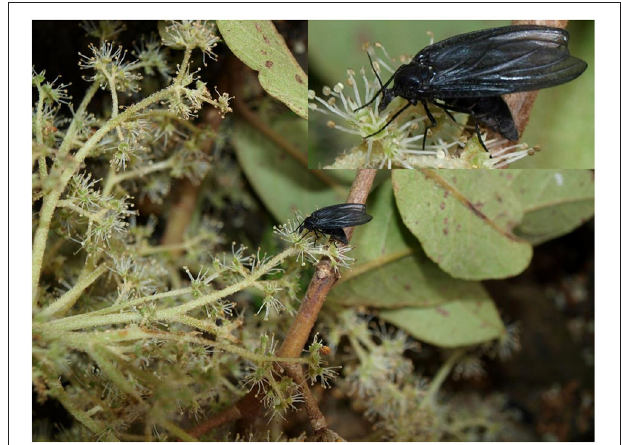
FIGURE 7 | An unknown fungus gnat species belonging to the genus Sciara (Sciaridae) visiting the flower nectaries of Hydrangea jelskii (Samain et al., 2011-059, Chachapoyas, Amazonas,